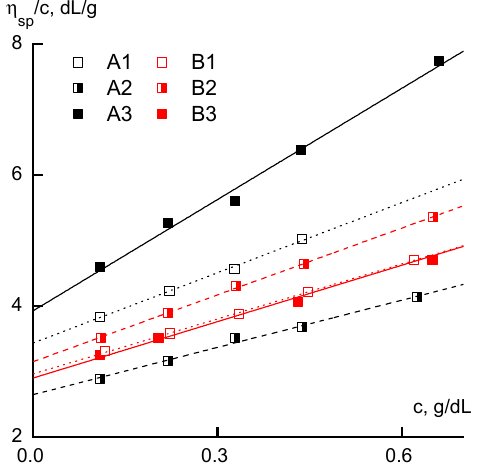
Figure 2. The dependence of the reduced viscosity on the concentration.